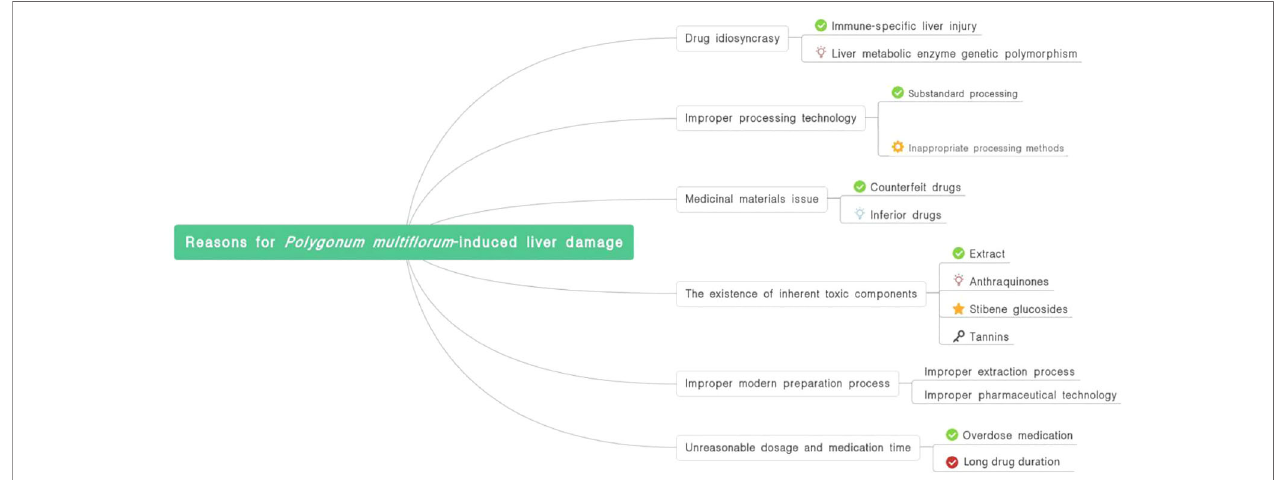
FIGURE 1 | Reasons for P. multi fl orum -induced liver